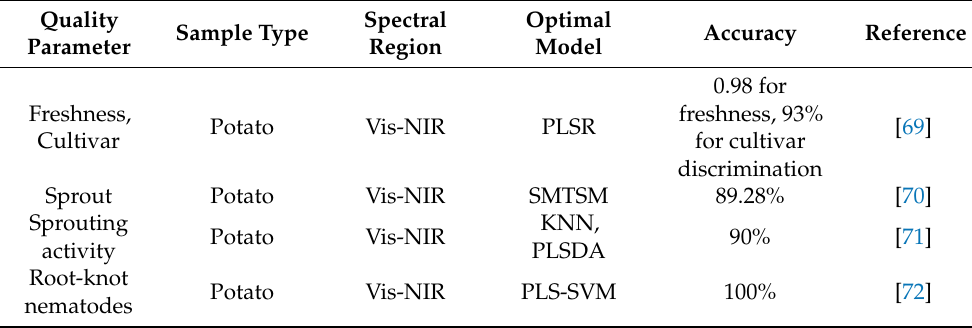
Table 1. Imaging spectroscopy for tuber quality